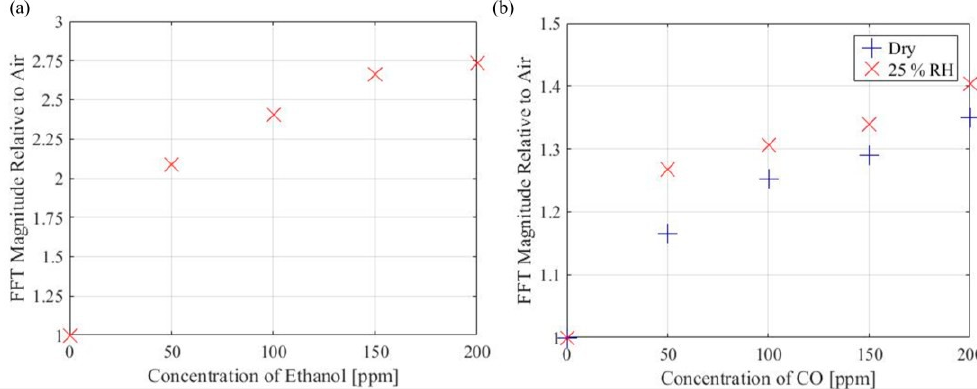
Figure 3. FFT magnitudes relative to a baseline of synthetic air calculated in real-time, ( a ) 2 Hz response when sensor exposed to ppm concentrations of ethanol (average of 10 samples), ( b ) 1 Hz response when exposed to ppm concentrations of CO (average of 10